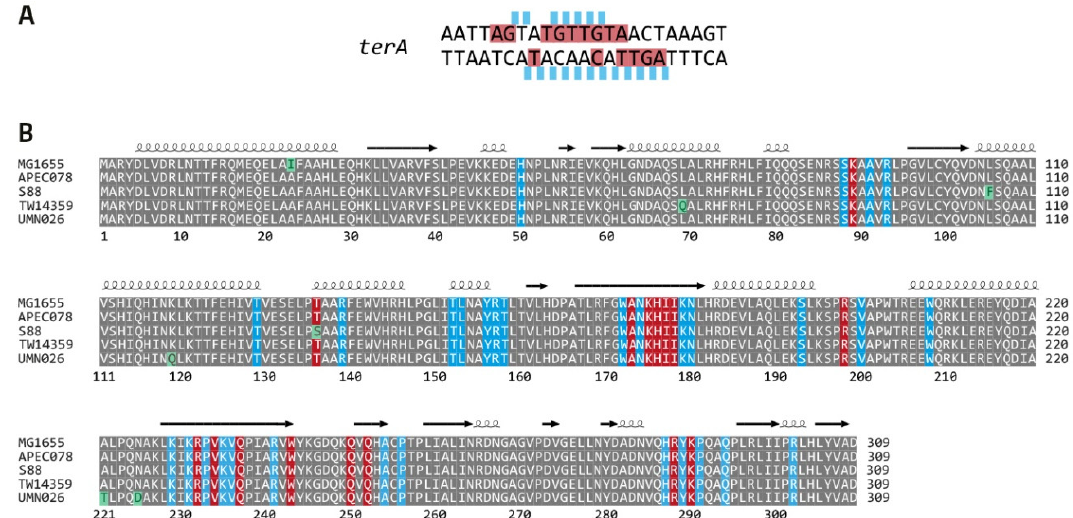
Figure 4. Interactions between Tus protein and ter sequences. ( A ) terA sequence in which interactions of Tus protein with the DNA backbone or individual bases is highlighted, as previously described [49]. Backbone contacts are shown in light blue above the terA sequence, where bases in direct contact with Tus are highlighted in red. ( B ) Sequence alignment of E. coli Tus proteins from the 5 phylogenetic groups. Identical residues are shaded grey, whereas any individual changes are highlighted in green. Those residues that interact with the DNA backbone of the terA sequence are highlighted by a blue block, while residues that make sequence-specific contacts with the terA DNA are highlighted with a red block, as described in [49]. Secondary structure information provided above is based on analysis using the ENDscript 2 server [54].